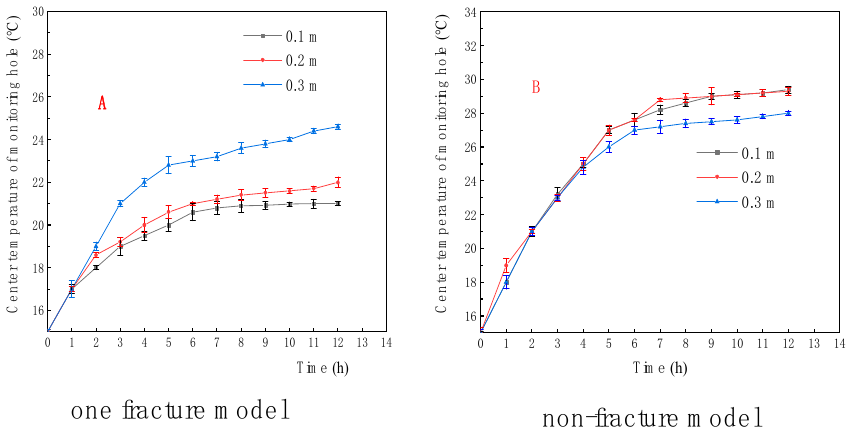
Figure 5. Curve of temperature change of the rock mass at different depths with time. ( A ) curve of the center temperature of the monitoring hole with time in one horizontal fracture model; ( B ) curve of the center temperature of the monitoring hole with time in a non-horizontal fracture model.